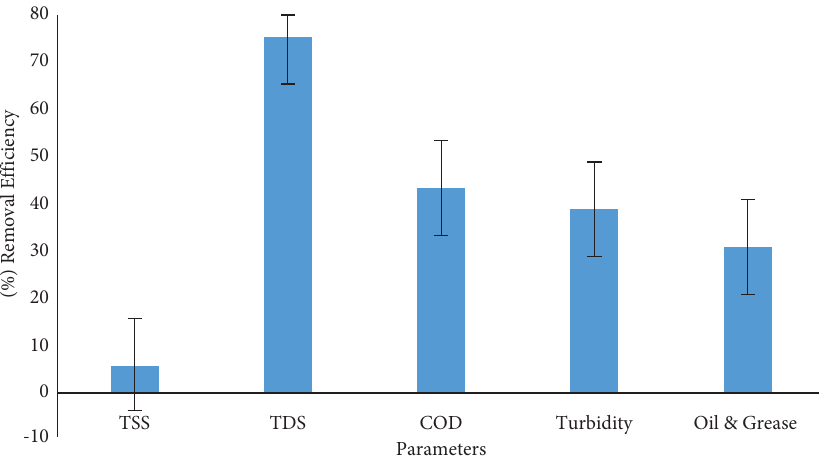
Figure 6: Percentage removal efciency of parameters with chitosan.